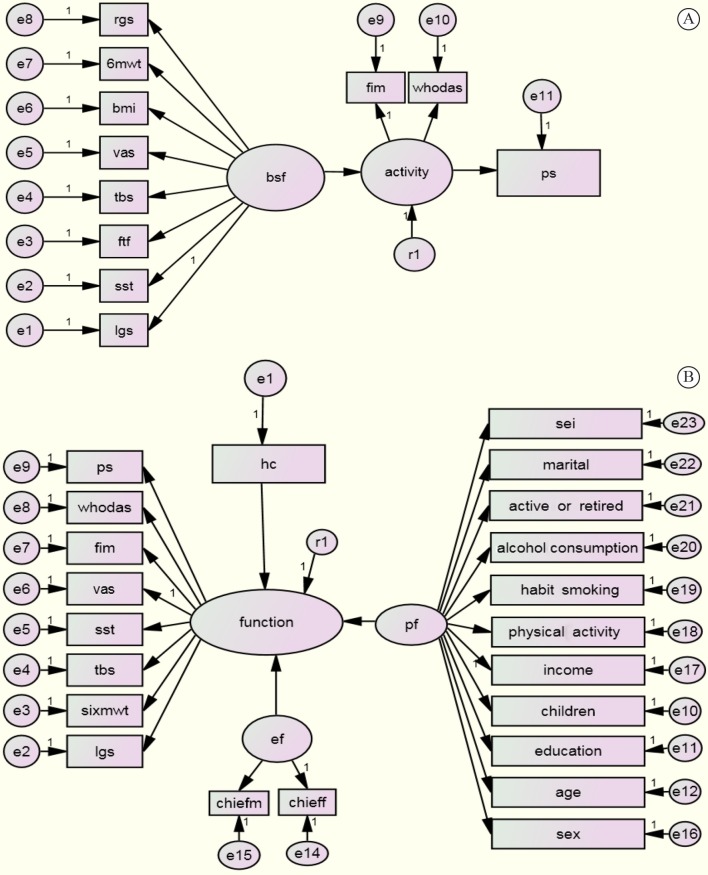
Graphic representation of the structural equation models exploring the relationships among factors representing components of the ICF model. Paths labeled with a “1” were used solely for identification and were therefore not tested. Ovals indicate latent constructs, while rectangles indicate subjacent constructs (i.e., the observed variables). Error values associated with each indicator are shown in small circles labeled with the letter “e”. Standard coefficients are shown above the structural paths between the latent constructs. Standard factorial loads are indicated between the latent constructs and the indicators. Residual errors associated with each latent variable are shown in small circles labeled with the letter “r”. Figure legends: 6MWT: six minute walking test; activeorretired: active at work or retired; age: age in years; alcoholconsumption: regular consumption of alcoholic beverage; vas: visual analog scale; bmi: body mass index; bsf: body structure and function; chieff: frequency of Craig Hospital Inventory of Environmental Factors; chiefm: magnitude of Craig Hospital Inventory of Environmental Factors; children: number of children; education: years of education; ef: environmental factors; function: integration of the components body structure and function, activity, and participation; fim: Functional Independence Measure; ftf: Fingers-to-Floor Test; habitsmoking: smoking; hc: health condition; income: annual income; lgs: left upper limb grip strength; marital: patient is living with partner; pf: personal factors; physicalactivity: regular practice of physical activity; ps: Participation Scale; rgs: right upper limb grip strength; sei: Socioeconomic Index of Occupations; sst: Sit-to-Stand Test; sex: sex of participants; tbs: Back Scratch Test; whodas: World Health Association Disability Assessment Instrument II.